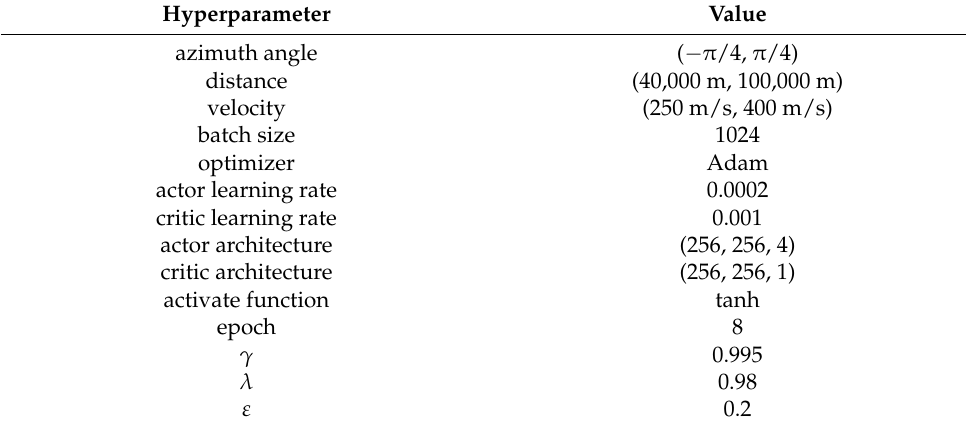
Table 2. Hyperparameters.